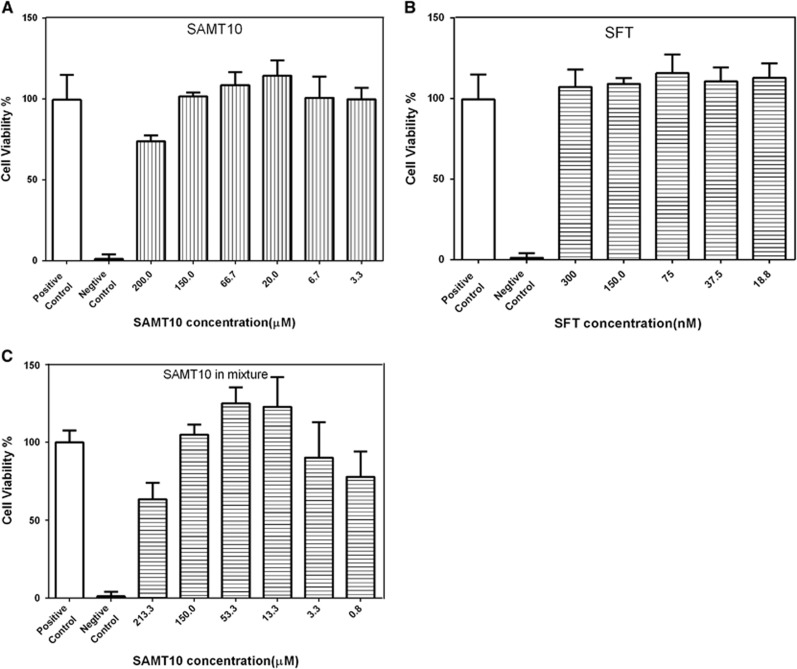
Assessment of SAMT10 and SFT cytotoxicity in cells. The viability of cells was tested for SAMT10 alone (A), SFT alone (B) or SAMT10 in combination with SFT (C). The range of doses for each compound tested was determined based on their EC50. Cell viability was quantified using the MTT method. Cells grown only in growth media served as the positive control, whereas cells cultured in 0.05% N-9 were the negative control. The percent cell viability was calculated by dividing the number of cells at each concentration of SAMT10 by the number of cells in the medium-only positive control. The results are representative of three independent experiments, and each experiment was performed in triplicate. The nontoxic dose of SAMT10 (maximal 150 μM) was used in subsequent experiments. 50% Effective concentrations, EC50; 3-(4,5-dimethyl-2-thiazyl)-2,5-diphenyl-2H-tetrazolium bromide, MTT; S-acyl-2-mercaptobenzamide thioester-10, SAMT10; sifuvirtide, SFT.